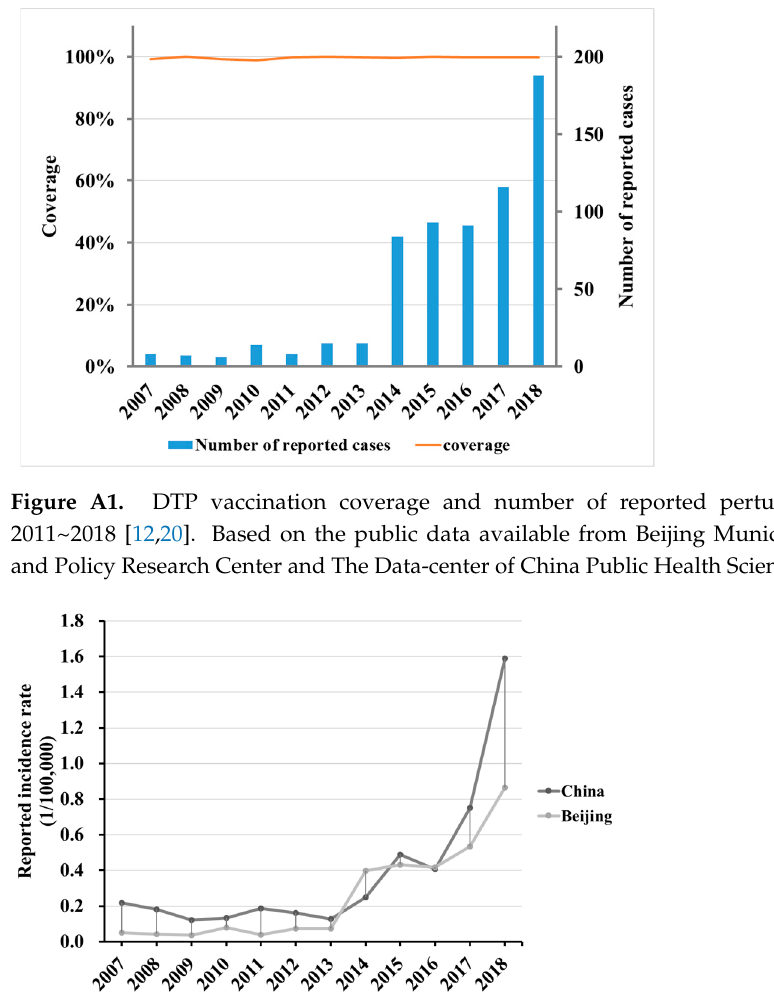
Figure A2. Reported incidence rate of pertussis all over China and in Beijing, 2011~2018 [12]. Based on the public data available from The Data-center of China Public Health Science.